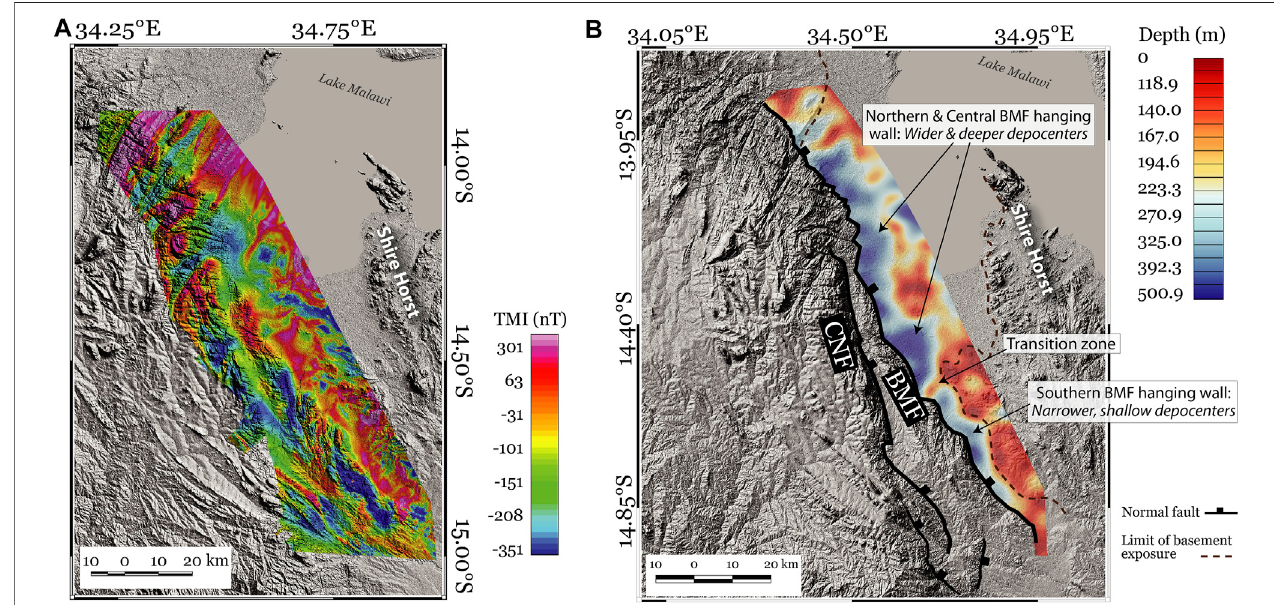
FIGURE5|(A) HillshademapofthestudyareaoverlaidwiththeTotal Magnetic Intensity (TMI)aeromagneticgrid, (B) Hillshade map ofthestudyareaoverlaid with the grid of depth-to-basement solutions estimated from aeromagnetic data, using the Source Parameter Imaging (SPI) technique.